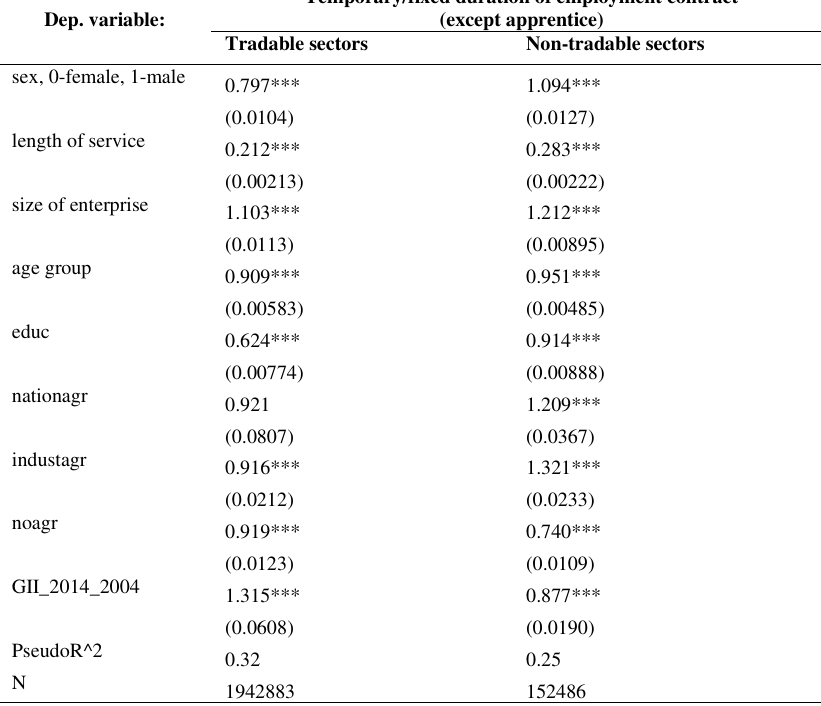
Table 3 . Estimation results – separately for tradable and non-tradable sectors Dep.